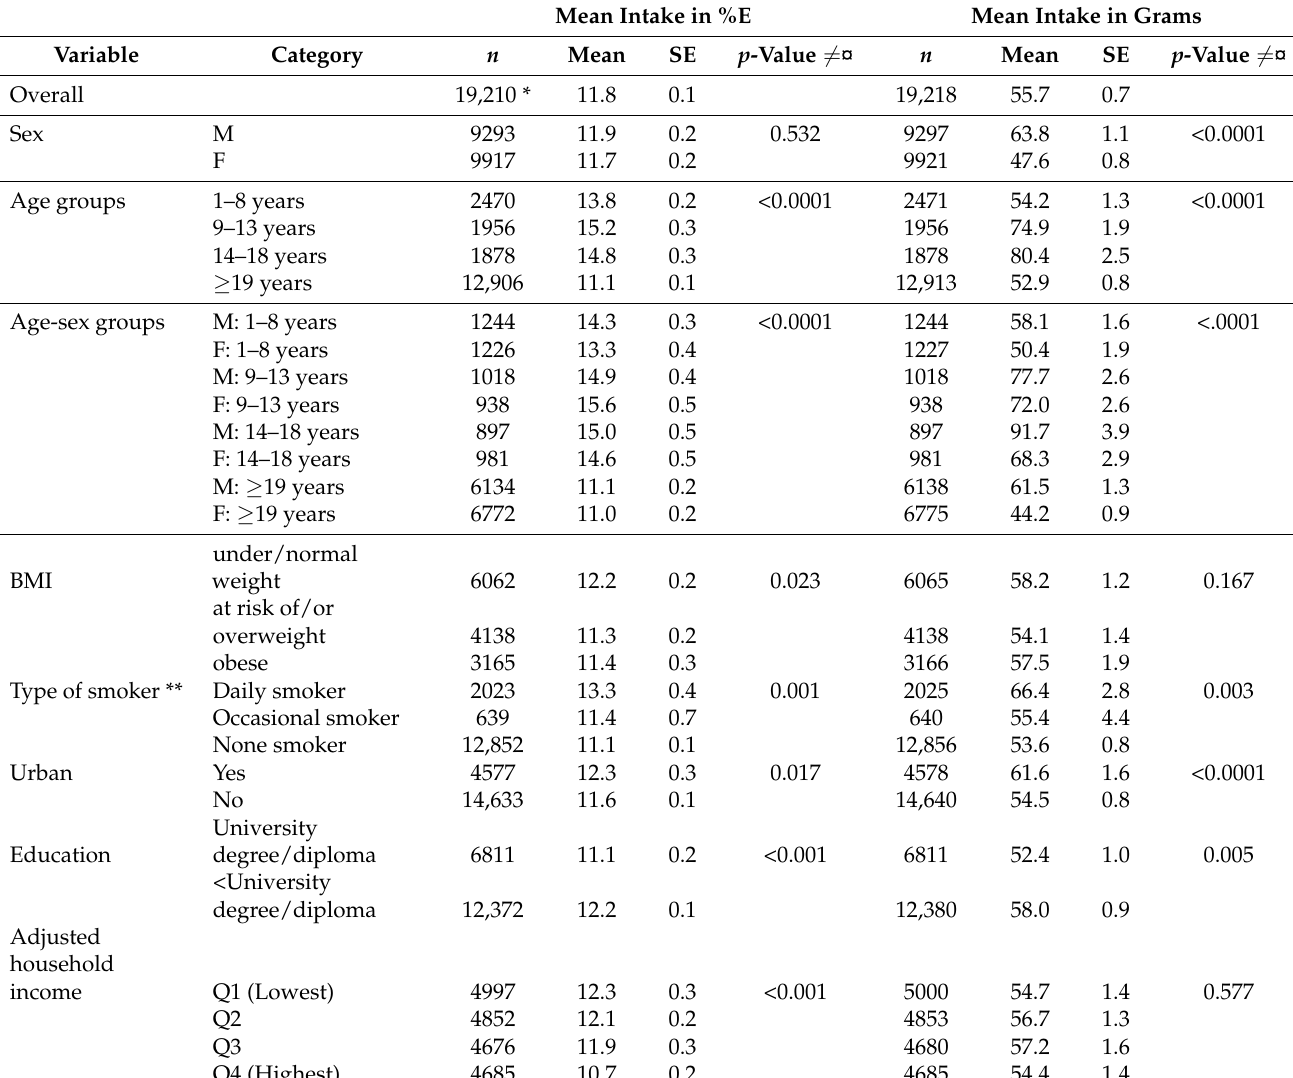
Table 1. Mean intake of free sugars from foods in the Canadian population ≥ 1